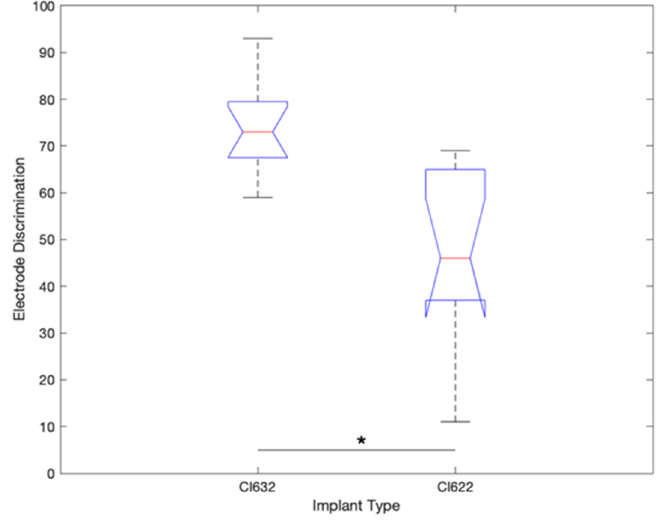
Figure 1. Electrode discrimination test result comparison chart between CI632 and CI622 recipients (* p < 0.05).